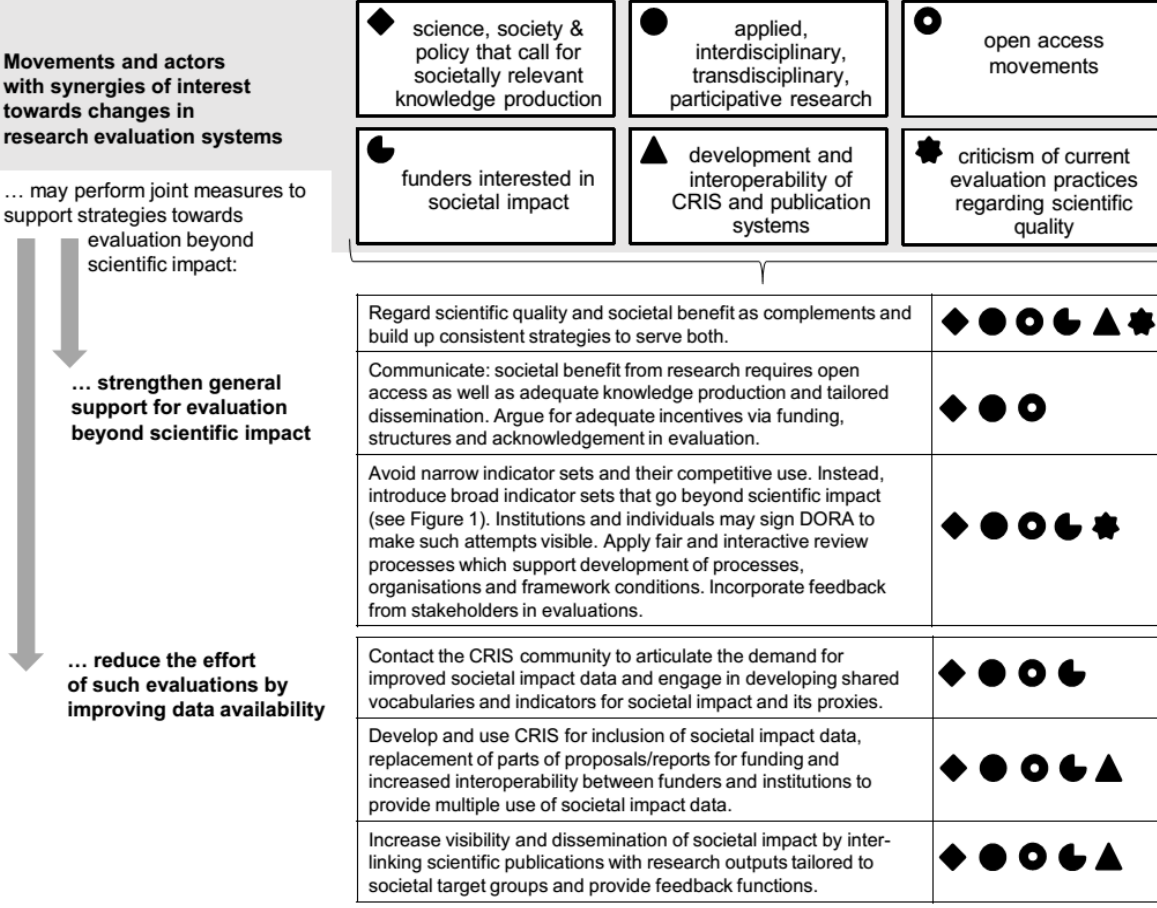
Figure 3. Supporting movements and joint measures to facilitate evaluation beyond scientific